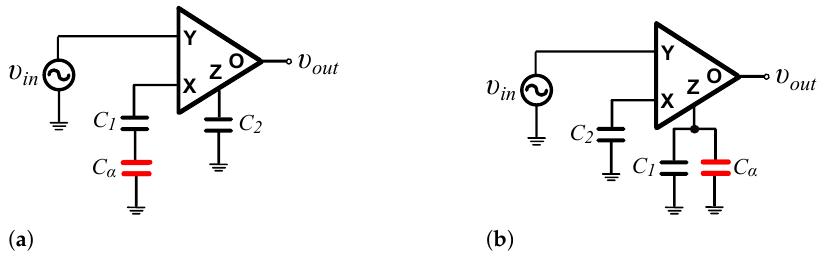
Figure 4. Implementations of fractional-order ( a ) low pass and ( b ) high pass filters with variable maximum